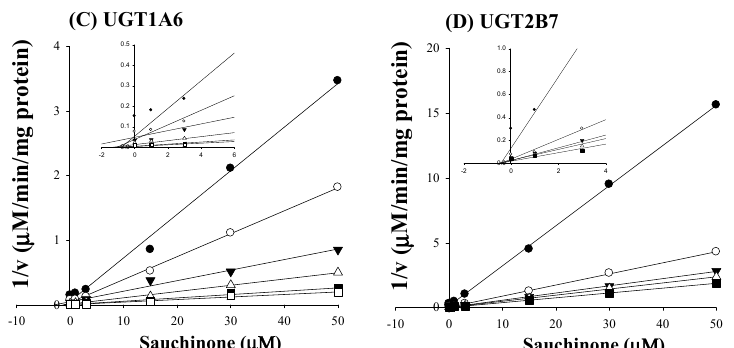
Figure 2. Inhibition of UGT1A6 and 2B7 by sauchinone. ( A ) The plot for velocities of UGT1A6-mediated serotonin glucuronidation versus serotonin concentrations depending on sauchinone concentrations. The following symbols ( ● , ○ , ▼ , △ , ■ , □ ) represent sauchinonne (as an inhibitor) concentrations of 0, 1, 3, 15, 30, and 50 μ M, respectively; ( B ) The plot for velocities of UGT2B7-mediated zidovudine glucuronidation versus zidovudine concentrations depending on sauchinone concentrations. The following symbols ( ● , ○ , ▼ , △ , ■ , □ ) represent sauchinonne (as an inhibitor) concentrations of 0, 1, 3, 15, 30, and 50 μ M, respectively; ( C ) Dixon plot of inhibitory effect of sauchinone on UGT1A6- mediated serotonin glucuronidation activity. The following symbols ( ● , ○ , ▼ , △ , ■ , □ ) represent sauchinonne (as an inhibitor) concentrations of 0, 1, 3, 15, 30, and 50 μ M, respectively; ( D ) Dixon plot of inhibitory effect of sauchinone on UGT2B7-mediated zidovudine glucuronidation activity. The following symbols ( ● , ○ , ▼ , △ , ■ , □ ) represent sauchinonne (as an inhibitor) concentrations of 0, 1, 3, 15, 30, and 50 μ M, respectively.